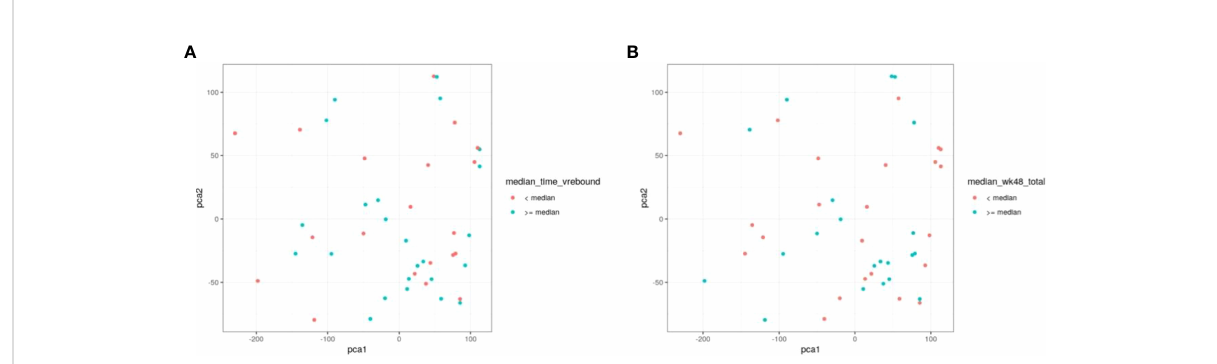
FIGURE 6 PCA does not discriminate between individuals based on time to viral rebound or total HIV DNA. NK cell markers and viral measurements were combined and analysed using PCA. In (A) red circles represent individuals with time to viral rebound < 6 weeks and blue circles indicate individuals with time to viral rebound ≥ 6 weeks. In (B) red circles represent individuals with HIV DNA levels < median and blue circles indicate individuals with ≥ median HIV DNA